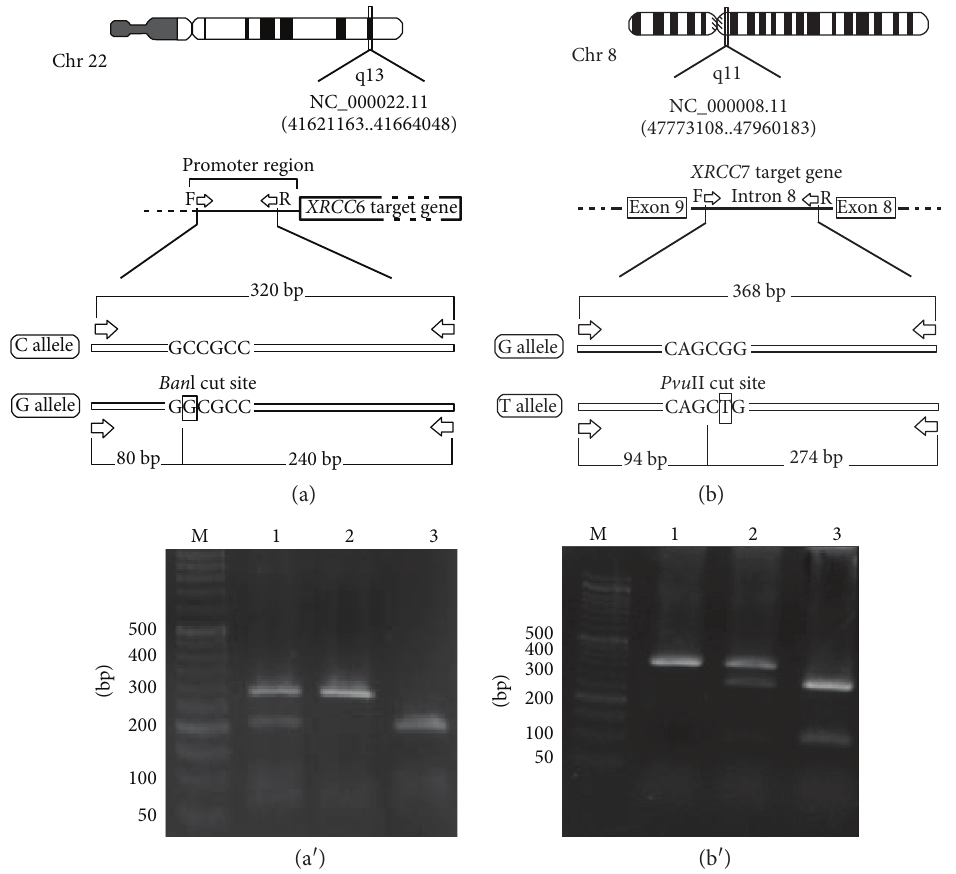
Figure 2: Schematic diagram and results of the PCR-RFLP products of XRCC6 and XRCC7: (a) schematic diagram of XRCC6 -61C > G, which showed BanI restriction enzyme site; (a ′ ) polymorphism of PCR-RFLP products of the XRCC6 -61C > G gene in 1% agarose gel electrophoresis. Lane M: 50bp DNA ladder; lane 1: CC homozygous genotype; lane 2: CG heterozygous genotype; lane 3: GG homozygous genotype; (b) schematic diagram of XRCC7 6721G > T which showed PvuII restriction enzyme site; (b ′ ) polymorphism of PCR-RFLP products of the XRCC7 6721G > T gene in 1% agarose gel electrophoresis, lane M: 50 bp DNA ladder; lane 1: GG homozygous genotype; lane 2: GT heterozygous genotype; lane 3: TT homozygous